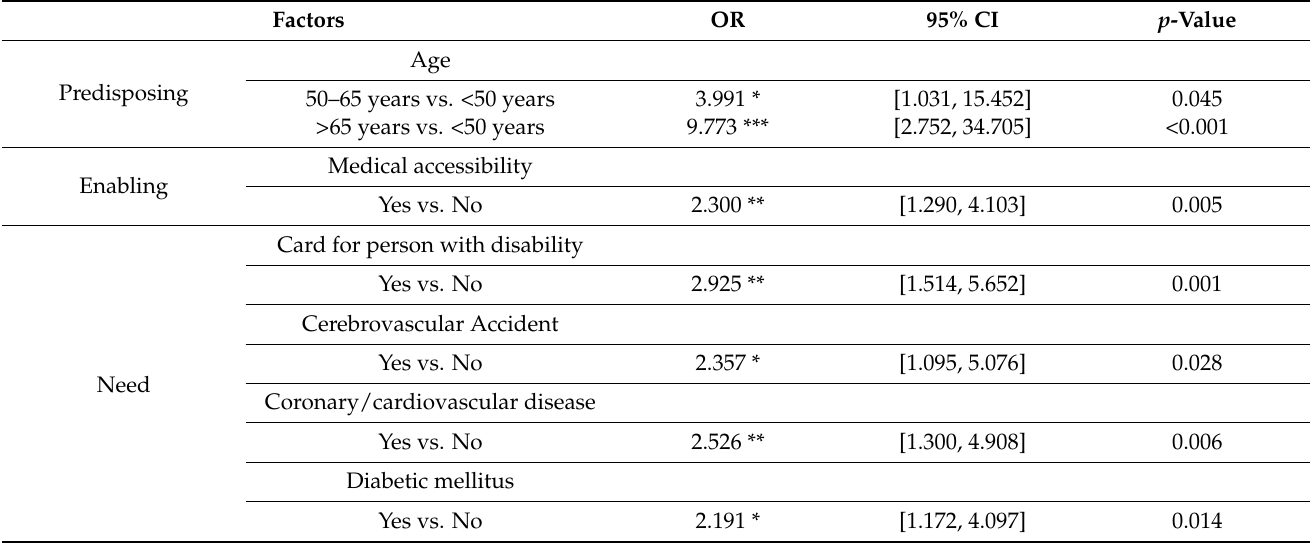
Table 3. Logistic regression model for factors of discharge planning on referrals to long-term care 2.0 (N =